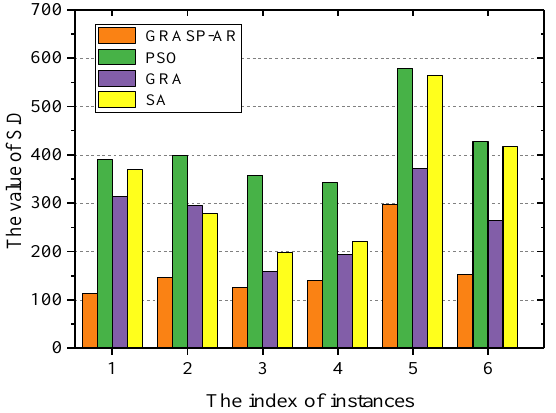
Figure 5. Standard deviation (S.D) histogram of real-world dataset under different gain-cost models.